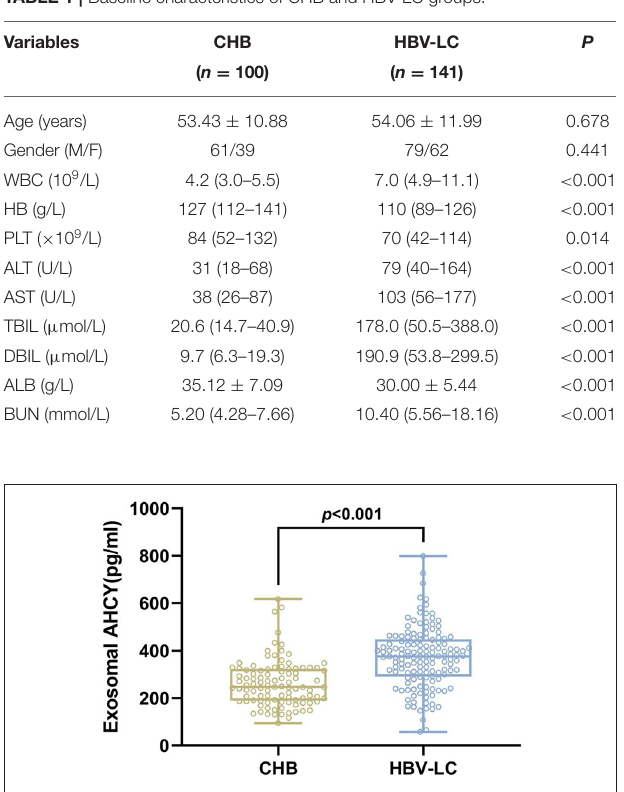
TABLE 1 | Baseline characteristics of CHB and HBV-LC groups.